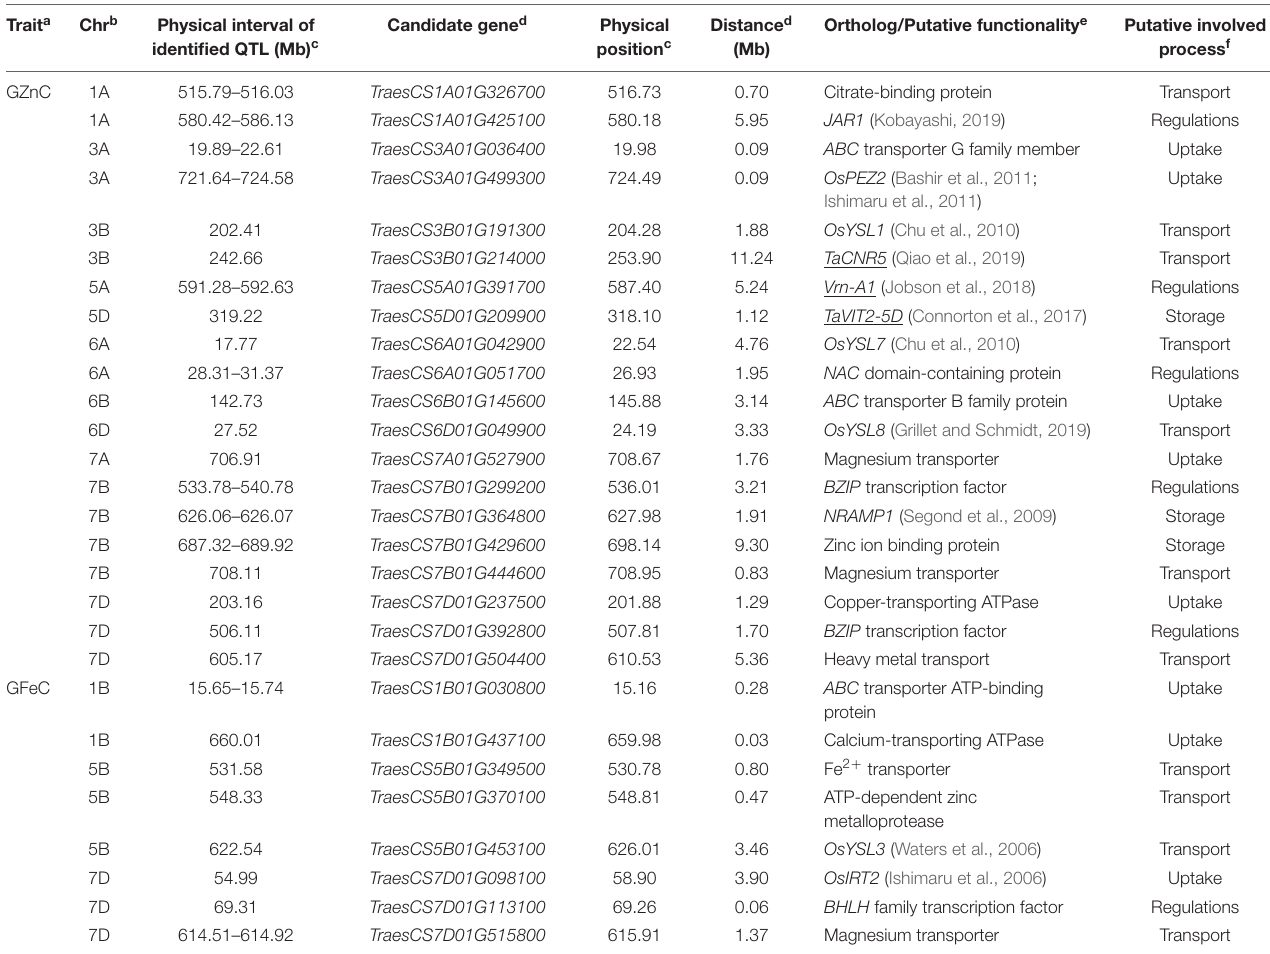
TABLE 3 | Putative candidate genes underlying the loci associated with GZnC and GFeC. Trait a Chr b Physical interval of Candidate gene identified QTL (Mb) c